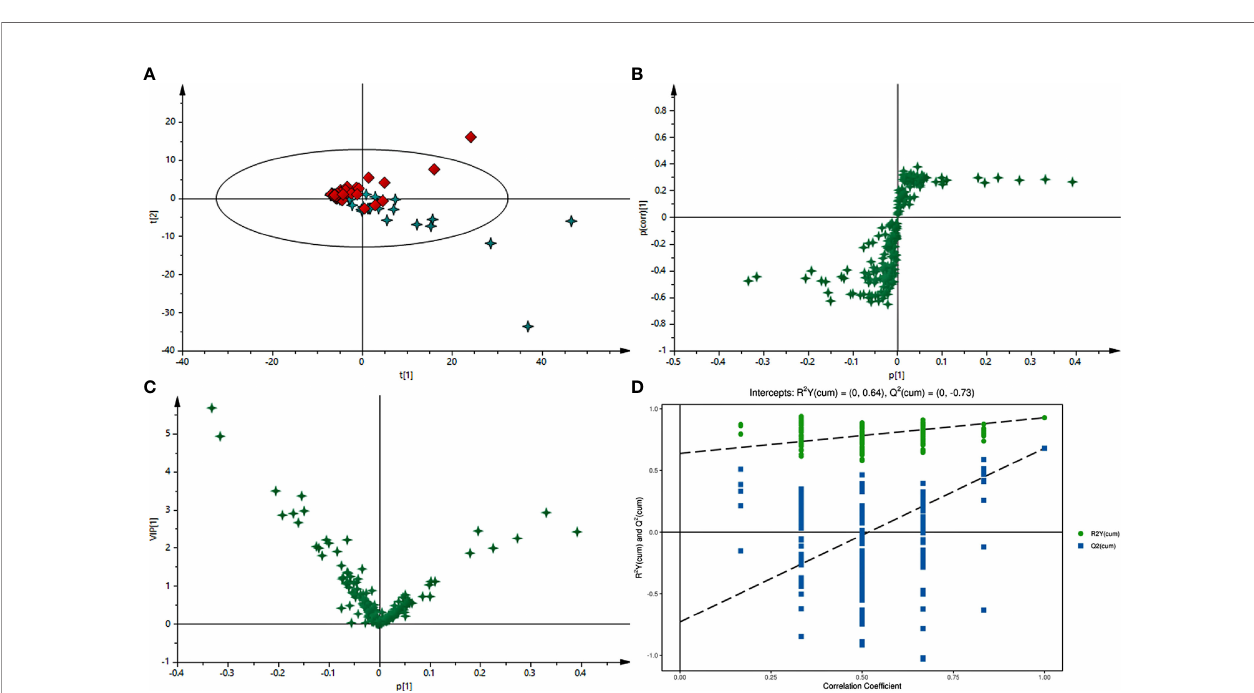
FIGURE 4 | (A) PCA score plot of preoperative and postoperative serum of 2-week samples in positive-ion mode with the statistical parameters (R 2 X = 0.965, Q 2 = 0.823). (B) S-plot of OPLS-DA with the statistical parameters in positive-ion mode (R 2 X = 0.939, R 2 Y = 0.639, Q2 = 0.844). (C) VIP value plot between preoperative and postoperative serum of 2-week samples in positive-ion mode. (D) Validation plot of the preoperative and postoperative serum of 2-week samples in positive-ion mode obtained from 200 permutation